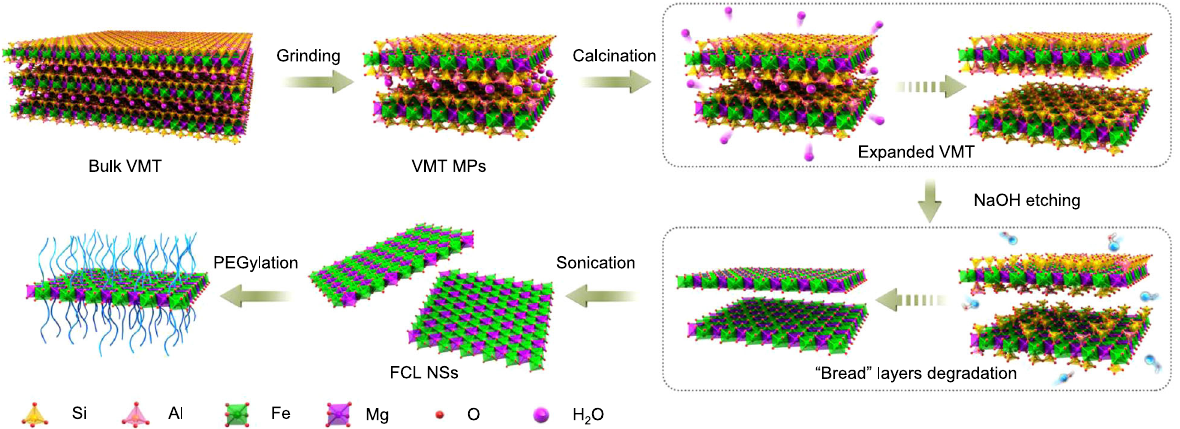
Fig. 1 Schematic illustration of preparation processes of FCL-PEG NSs. The FCL NSs were prepared by coupling grinding, calcination, alkali etching, and liquid exfoliation. VMT vermiculite, MPs microparticles, FCL NSs functional core